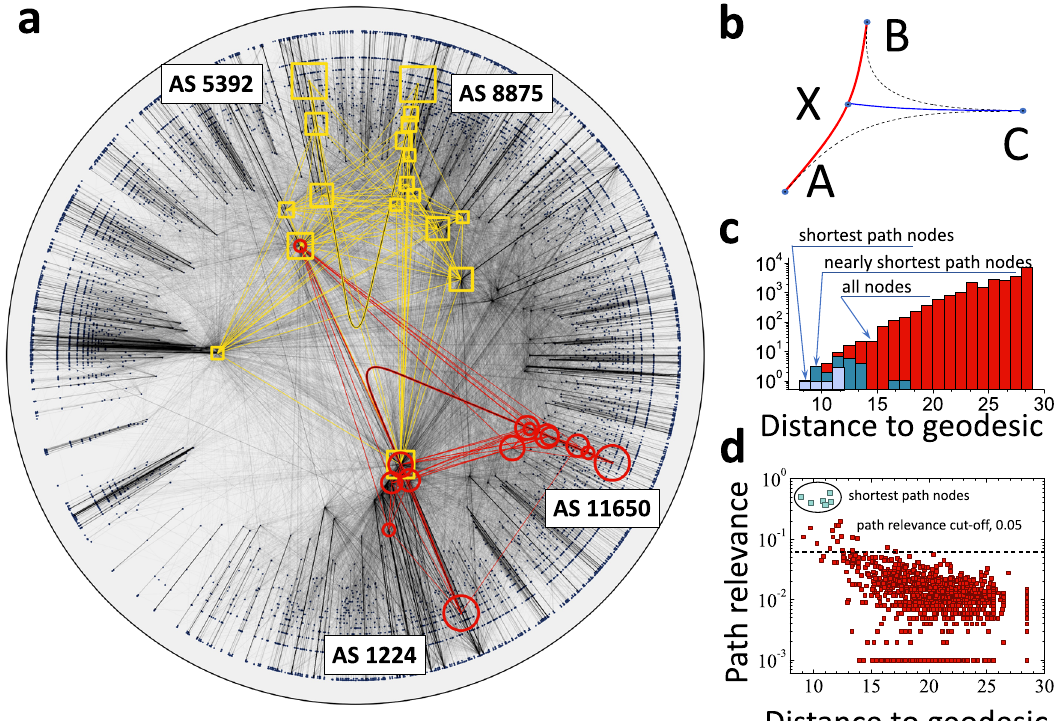
Fig. 1 | Latent geometry uncovers shortest and nearly shortest paths in the InternetattheAutonomousSystemlevel.a HyperbolicmapoftheInternetatthe Autonomous System (AS) level. See Section SV for data collection and hyperbolic mapping details. The latent space is the 2-dimensional hyperbolic disk and each point corresponds to an Autonomous System. Yellow squares and red circles highlight ASes corresponding to communication paths between AS5392-AS8875 andAS1224-AS11650pairs.Shownarethenodeswithpathrelevanceexceeding0.1,